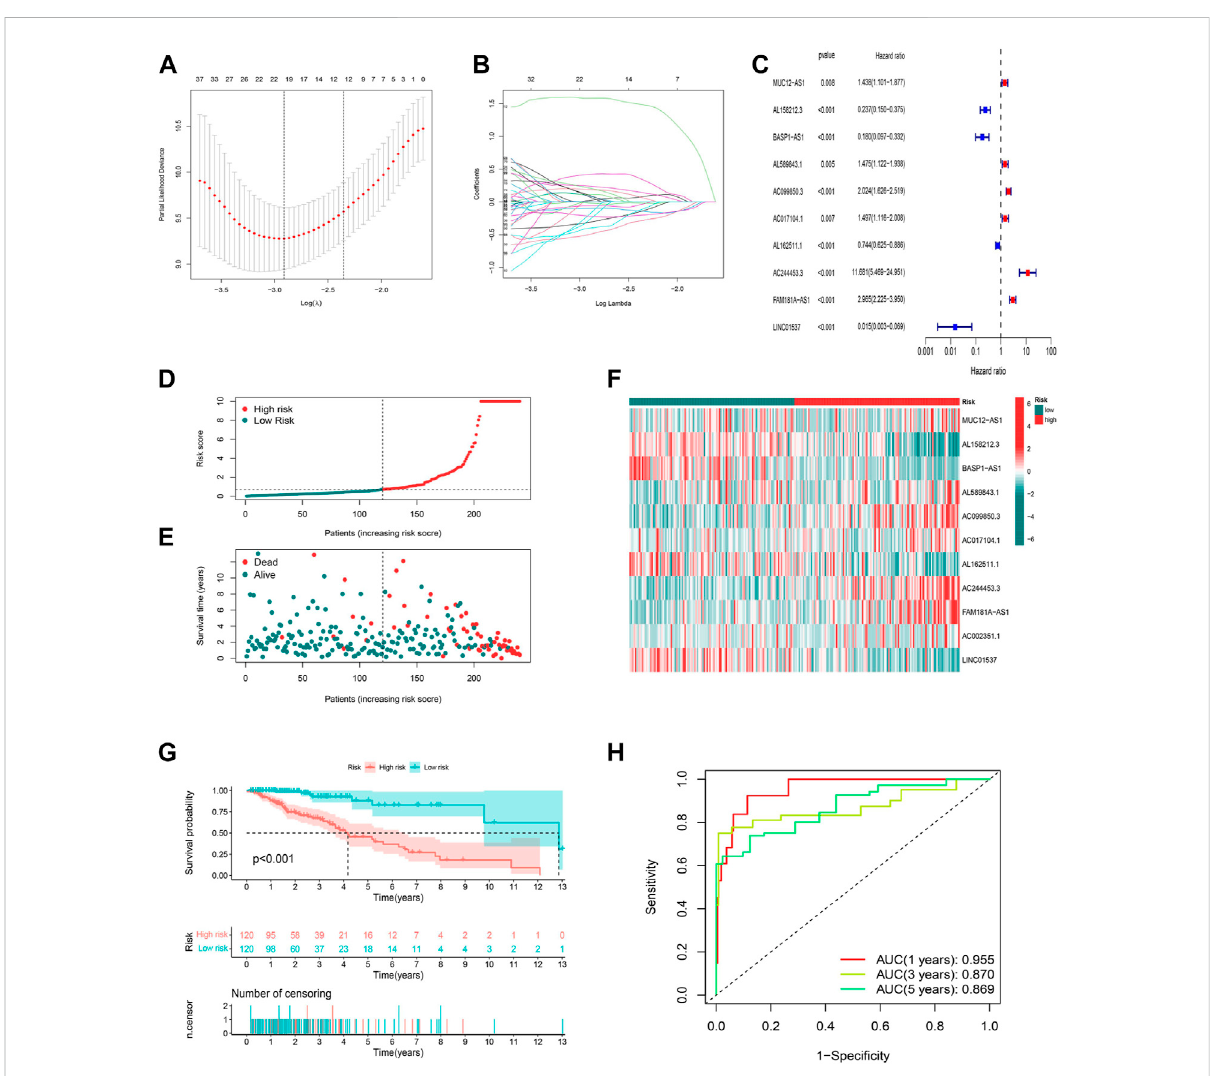
FIGURE 3 ConstructionandvalidationoftheprognosticmodelintheTCGAtrainingset. (A) TheLASSOcoef fi cientpro fi leofcuproptosis-relatedlncRNAs. (B) The 10-fold cross-validation for variable selection in the LASSO model. (C) Multivariate Cox regression analysis showed six independent prognostic lncRNAs. (D) Distribution of cuproptosis-related lncRNAs model-based risk score for the training set. (E) Different patterns of